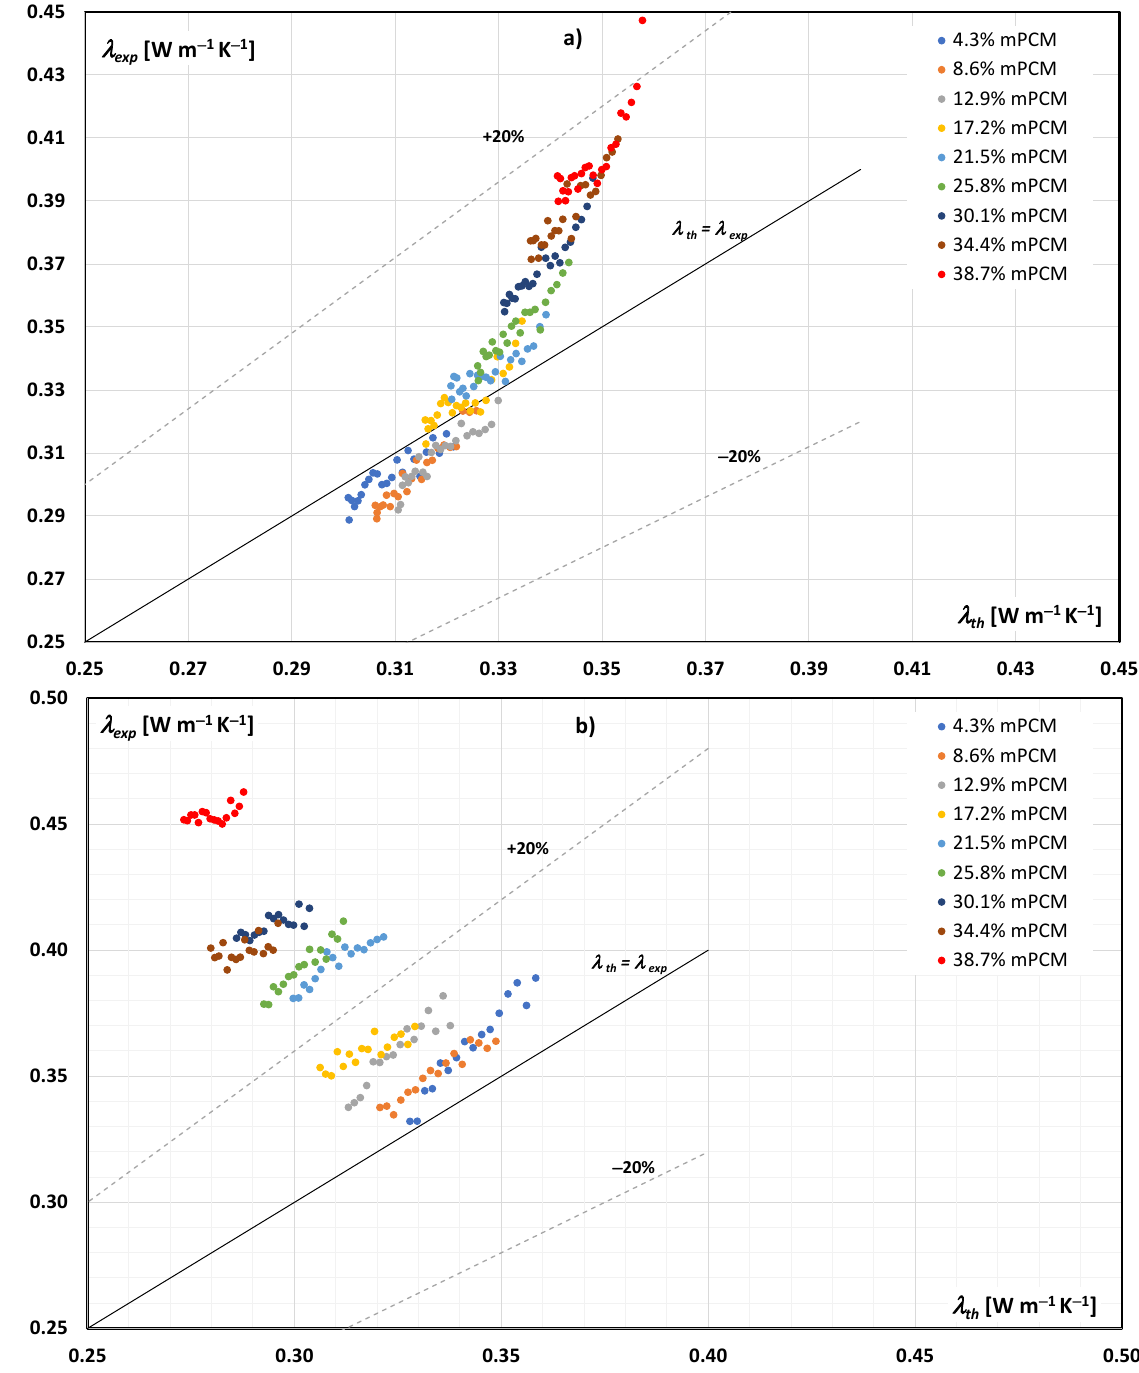
Figure 5. Comparison of the experimental and theoretical (according to Maxwell’s dependence) thermal conductivity of mPCM slurry based on an aqueous solution of propylene glycol: ( a ) PCM in the form of a solid, ( b ) PCM in the form of a liquid.